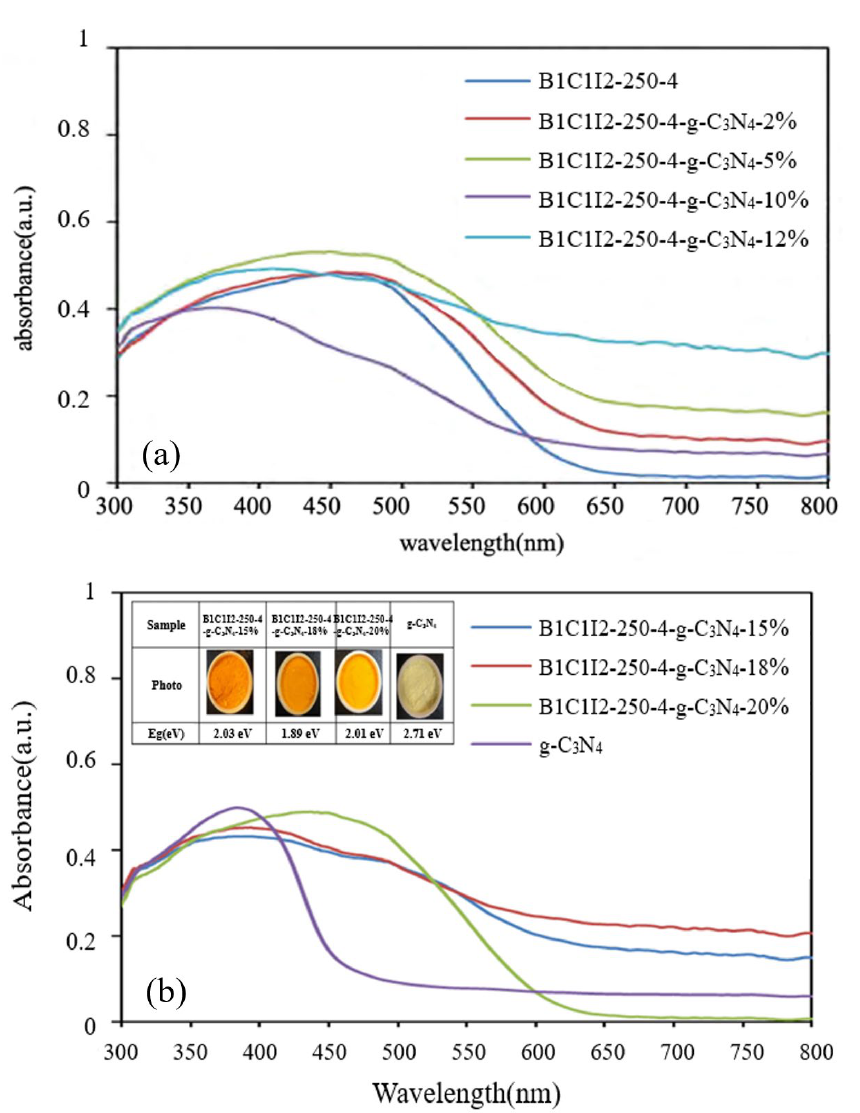
Figure 4. UV–vis absorption spectra of BiO m Cl n /BiO p I q /g-C 3 N 4 photocatalysts with different g- C 3 N 4 contents that were prepared under a KCl:KI molar ratio of 1:2, a hydrothermal temperature of 250 °C, and a pH of 4: ( a ) photocatalysts with g-C 3 N 4 contents of 2%, 5%, 10%, and 12%; ( b ) photocatalysts with g-C 3 N 4 contents of 15%, 18%, and 20%.